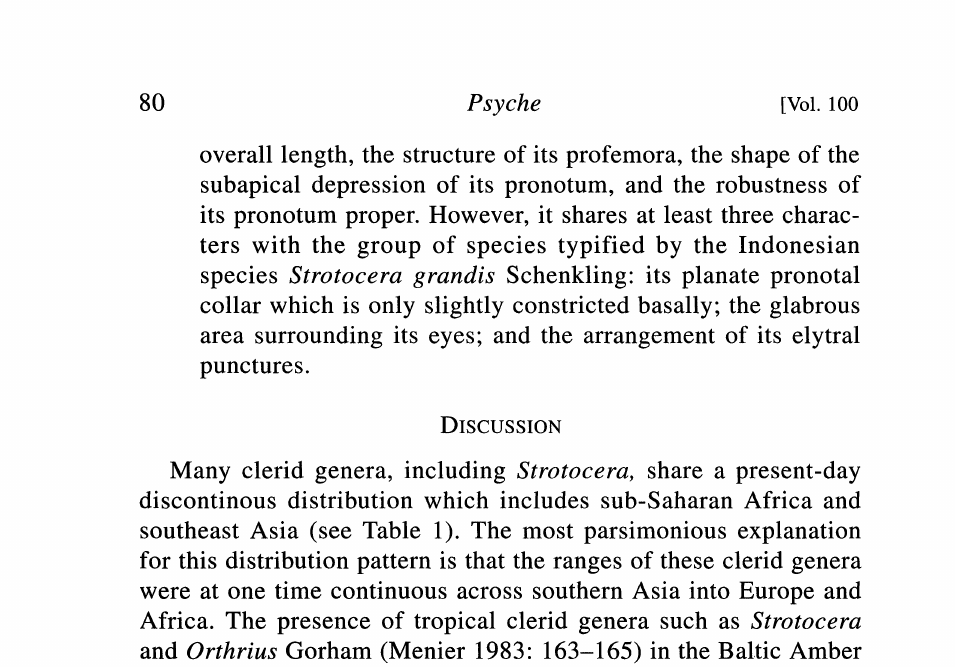
Table 1. Clerid Genera with Discontinuous Distributions between Sub-Saharan Africa and Southeast Asia. Clerid